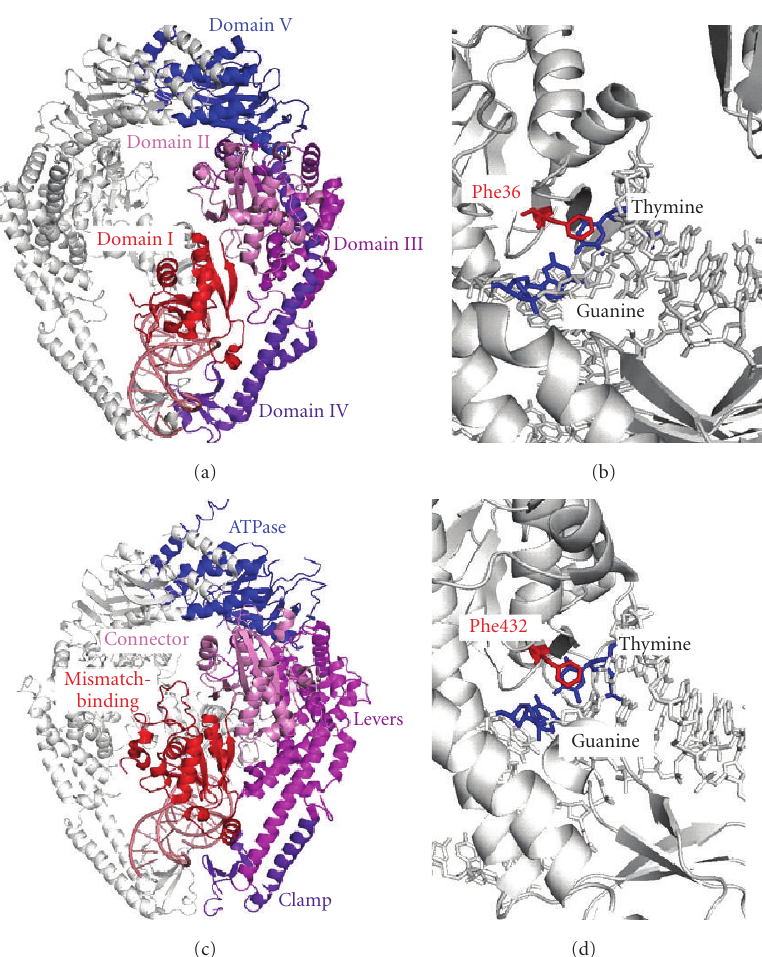
Figure 4: Crystal structures of MutS-mismatch complex. (a) Crystal structure of E. coli MutS bound to a G:T-mismatched heteroduplex (PDB ID: 1E3M). One of the 2 subunits of E. coli MutS is shown in color. DNA is shown in salmon. Domains I, II, III, IV, and V are shown in red, pink, violet, purple blue, and blue, respectively. Domains I, IV, and V are responsible for mismatch recognition, double-stranded DNA binding, and dimerization/ATP binding, respectively. (b) The mismatch-recognition site in E. coli MutS-G:T mismatch complex. The mismatch-recognizing phenylalanine residue (Phe36) and G:T mismatch are shown in red and blue, respectively. (c) Crystal structure of human MutS α (PDB ID: 2O8B), which is comprised of full-length MSH2 and a protease-resistant fragment of MSH6 lacking the first 340 amino acid residues. MSH2 is shown in white and MSH6 is in color. Mismatch-binding, Connector, Levers, Clamp, and ATPase domains are colored in red, pink, magenta, purple, and blue, respectively. (d) The mismatch-recognition site in human MutS α -G:T mismatch complex. Phe432 and G:T mismatch is shown in red and blue,